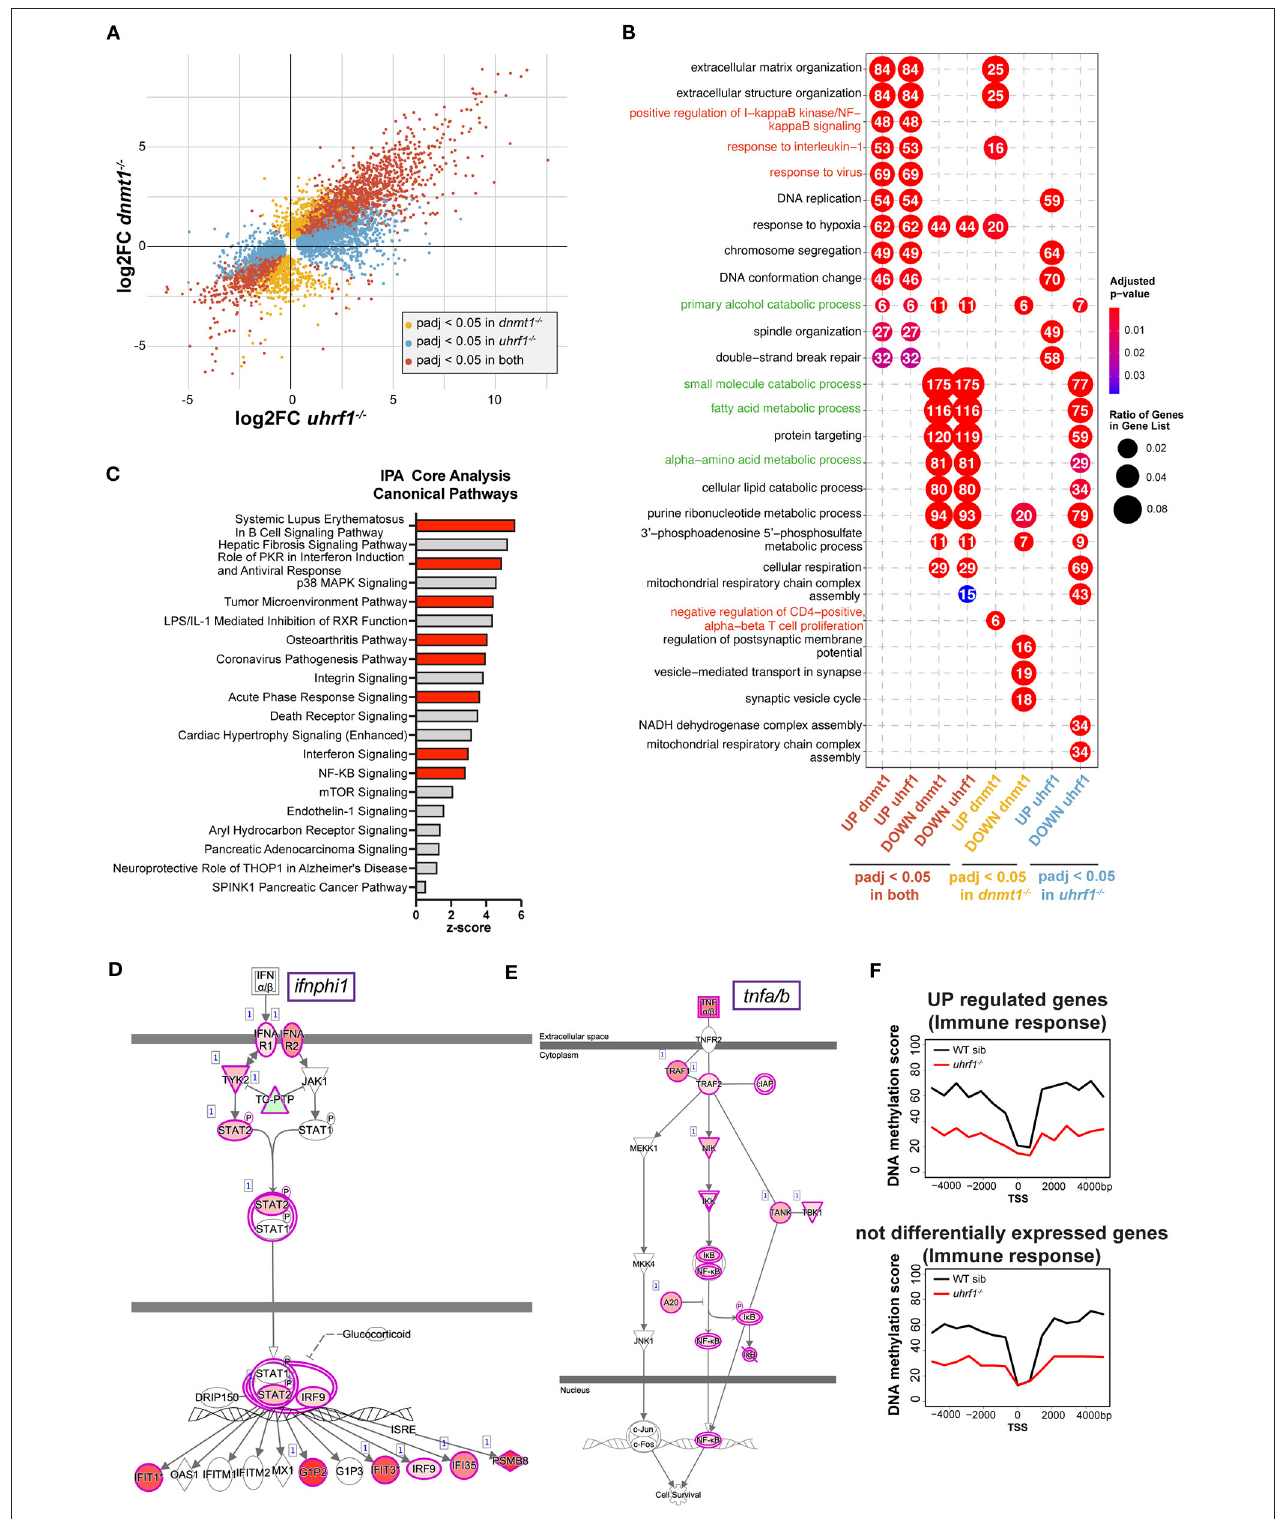
FIGURE 4 | dnmt1 and uhrf1 loss activates typeI interferon and NF-kB mediated immune response. (A) RNAseq analysis of RNA extracted from uhrf1 − / − and dnmt1 − / − mutant livers. Four quadrants plot of log 2 fold change of uhrf1 − / − and dnmt1 − / − mutant livers calculated on their own WT siblings. The genes that